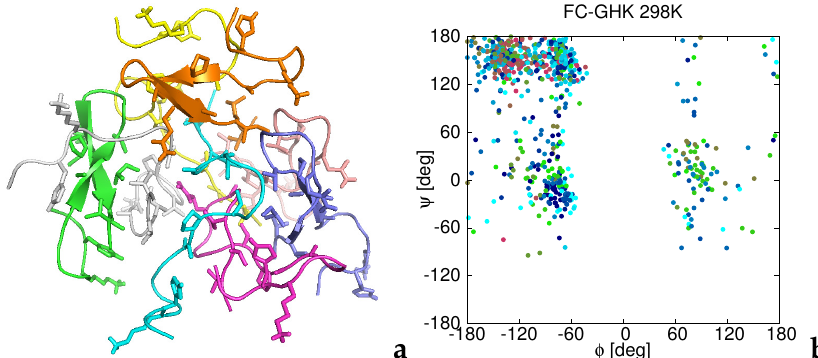
Figure 6. A representative structure of the octamer of FC-GHK at T = 298 K obtained in MREMD simulations of the corresponding eight-chain system ( a ) and a plot of the backbone φ and ψ angles collected from all five models obtained by the cluster analysis at this temperature ( b ). Each chain in panel a is colored by a different color. Backbones are represented as ribbons and the side chains are shown in the stick representation. The structures were obtained by converting the UNRES chains into the all-atom representation. Each point in the ( φ , ψ ) -plots is colored according to residue index (chain index ignored), from blue to red from the N- to the C-terminus. The drawings were produced with PyMol [64] and gnuplot [57], respectively.